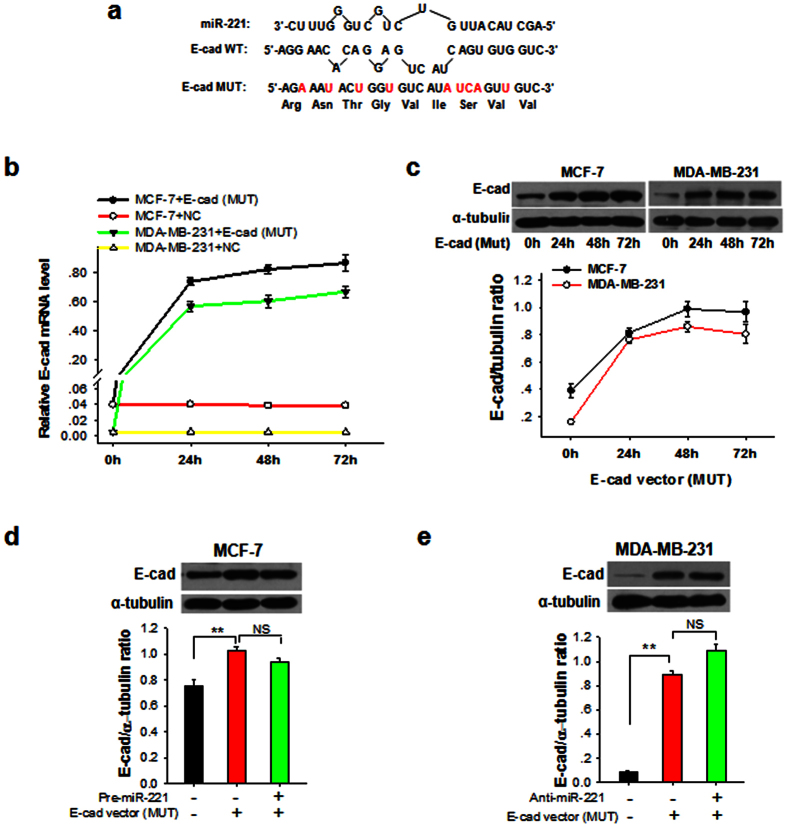
MDA-MB-231 cells can express functional E-cadherin that has the same amino acid sequence but not targeted by miR-221.(a) Construct of the vector encoding a mutated E-cadherin ORF (E-cad MUT) that has the same amino acids with WT E-cadherin but no miR-221 binding site. The mutated sites in E-cadherin MUT were marked in red. (b,c) E-cadherin mRNA levels (b) and protein levels (c) in MCF-7 and MDA-MB-231 cells transfected with E-cad MUT for 0, 24, 48 or 72 h. (d) E-cadherin protein levels in MCF-7 cells transfected with or without E-cad MUT and pre-miR-221. (e) E-cadherin protein levels in MDA-MB-231 cells transfected with or without E-cad MUT and anti-miR-221 ASO. Results are presented as the mean ± SEM (n = 3). NS, no significant difference, *P < 0.05. **P < 0.01.